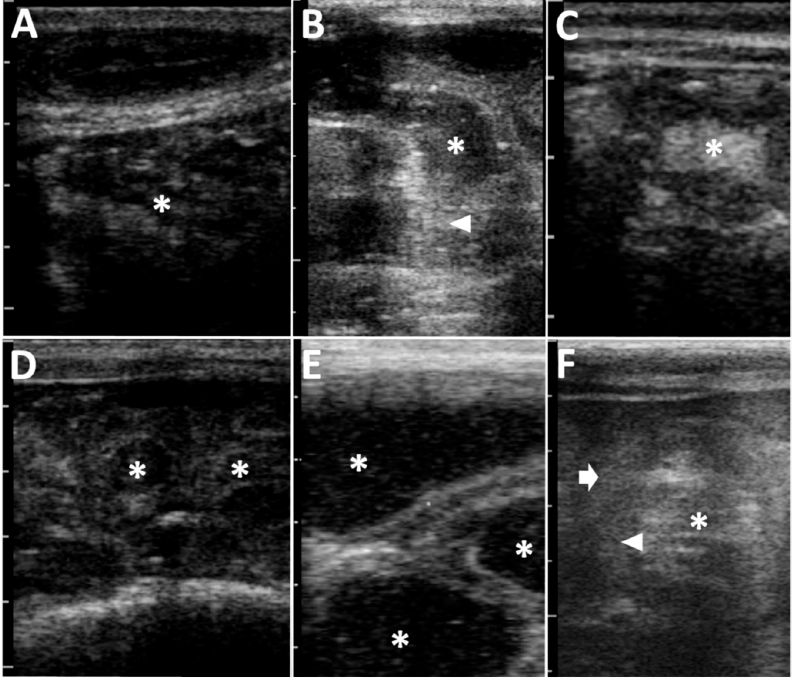
Figure 2. Abdominal ultrasonograms of Case 2 ( A ), Case 4 ( B ), Case 5 ( C ), Case 6 ( D ), Case 8 ( E ), and Case 9 ( F ). ( A ) The heterogeneously hypo- and hyper-echoic ingesta, including hyperechoic deposits, are seen to fully fill within the severely dilated lumen of the abomasum (asterisk). ( B ) In a longitudinal section, the dilated intestine includes the hypoechoic fluid contents with multiple hyperechoic deposits (asterisk). An acutely angled narrowing (arrowhead) is evident in the dilated, acutely curved intestinal loop. ( C ) In a cross section of the round, dilated intestinal loop, the hyperechoic contents (asterisk) are included in the thickened, hypoechoic wall. ( D ) The intraluminal contents are hypoechoic (asterisks) in multiple cross-sections of the dilated intestinal loops. ( E ) The hypoechoic contents with hyperechoic spots are included in the 1.5- to 3.0-cm-thick lumens of multiple, dilated intestinal loops (asterisk) seen on the same screen. ( F ) In the cross-section of the affected loop, the heterogenous hypo- and hyper-echoic contents (asterisk) are seen within the lumen surrounded by the thickened, hypoechoic, double, intestinal walls comprising of intussusceptum (arrowhead) and intussuscipiens (arrow). Scale bar = 10